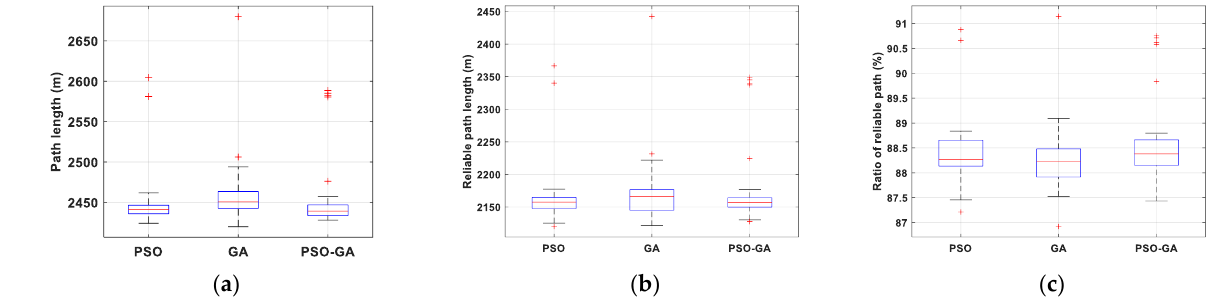
Figure 9. Statistical results of Scenario I: ( a ) optimal path, ( b ) reliable path, and ( c ) ratio of the reliable path.